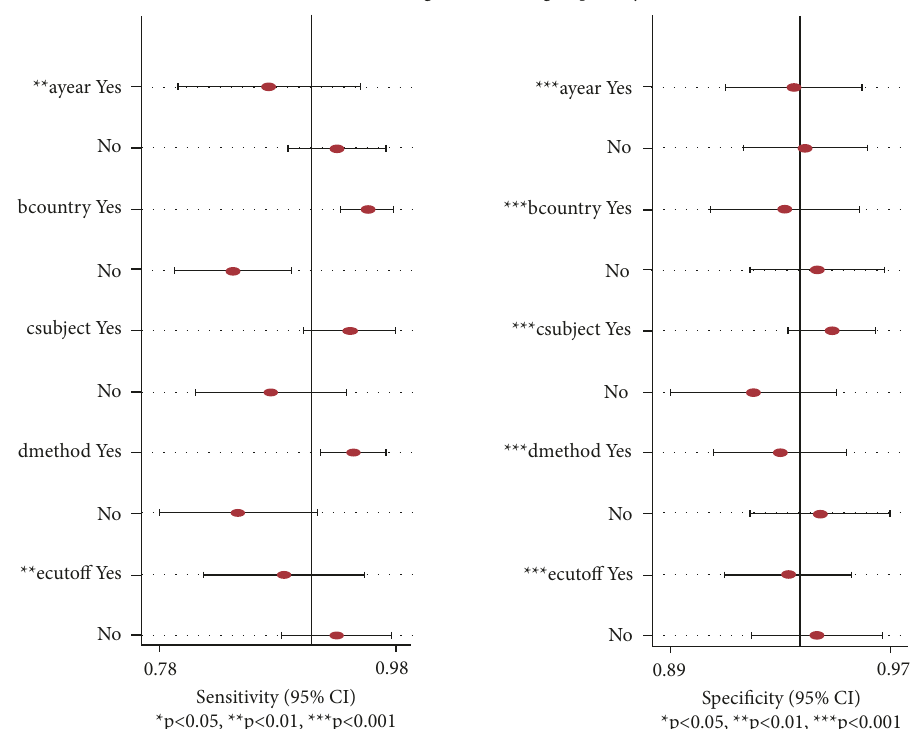
Figure 6: Meta-regression of the included studies. Both sensitivity and specificity were significantly affected by publication year and the cutoff value ( P < 0 . 05), indicating that publication year, cutoff value, and other unknown covariates result in